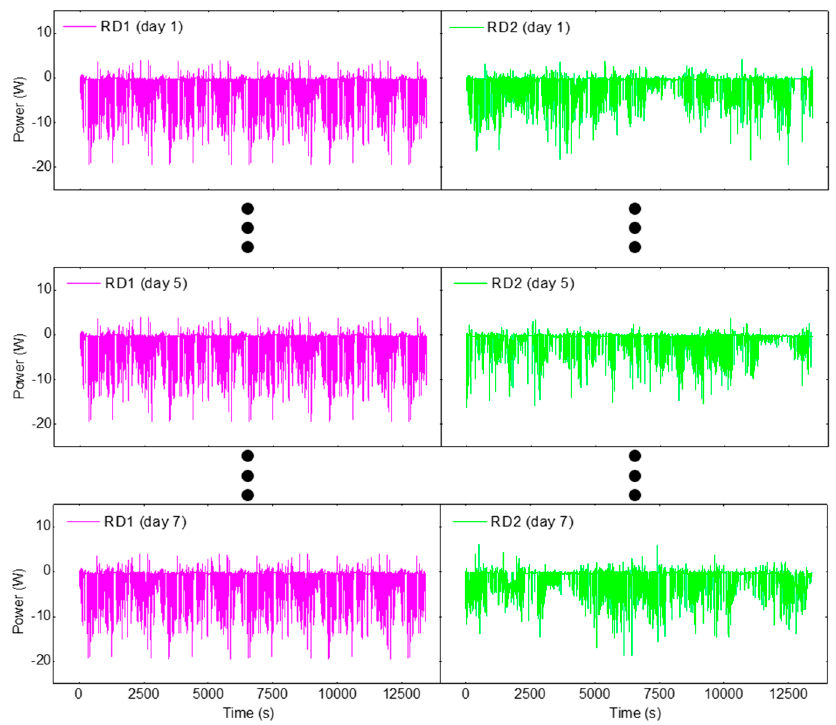
Figure 2. The power profiles from the real driving data (RD1 and RD2) selected from the Hawai’i Natural Energy Institute (HNEI) database.